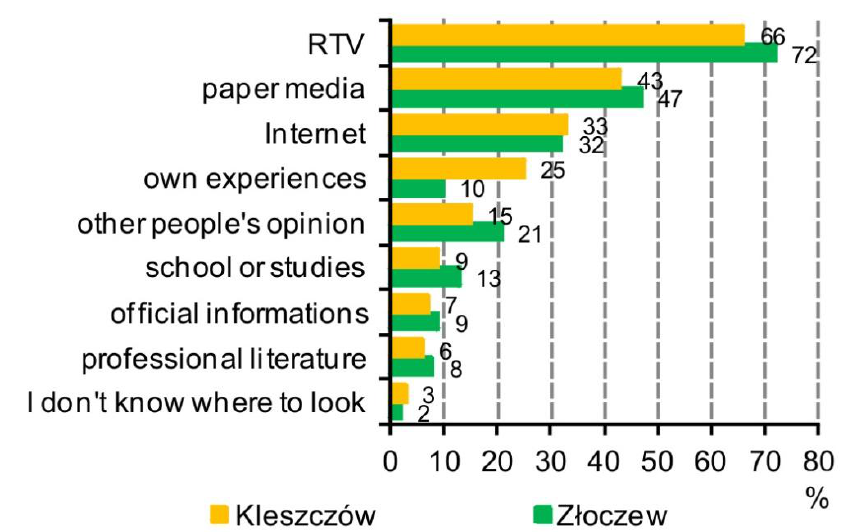
Fig. 3. What is your main source of information about resources excavation? Please indicate three from among the given ones. The inhabitants of the Kleszczów community (n = 300) and the Złoczew community (n = 302) separately (Source: Telephone interviewing (CATI), January-February